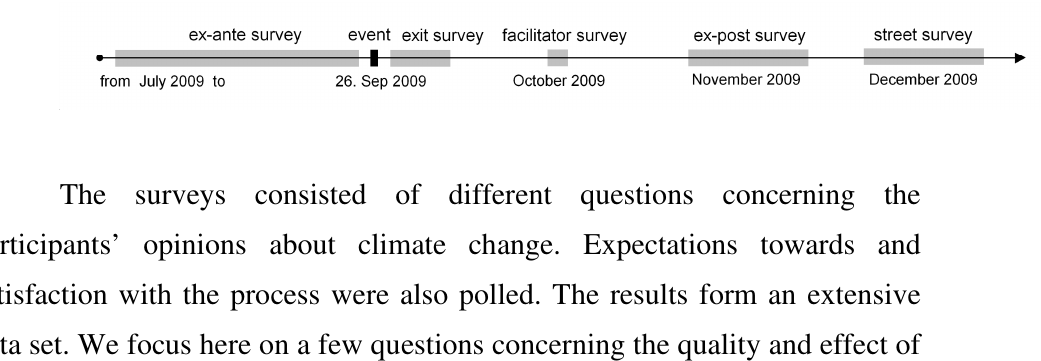
Figure 3. Timeline of surveys undertaken during the course of Austrian